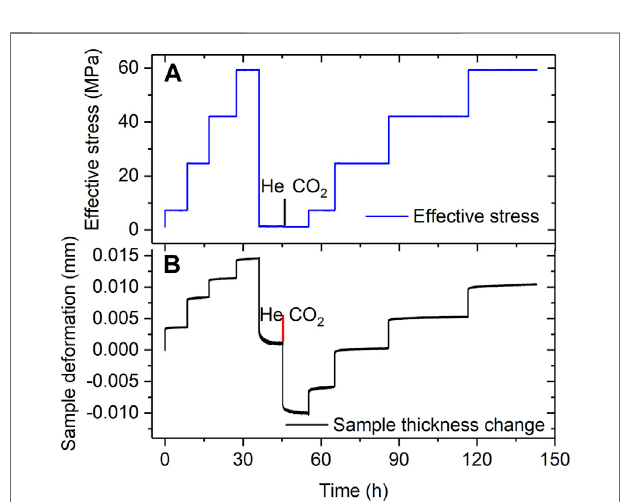
FIGURE 5 | Representative data obtained in Stage 3 experiments performed onVDsamplesusing pure(dry) He and CO 2 (illustrated here forthe VDCa-SAz-1sample). (A) StresspathemployedinrunsonVDsampleSAz-1, sequentially charged with dry He and dry CO 2 at a pressure of 10 MPa. (B) Corresponding sample thickness change versus experimental time. All data measured relative to the starting state in the Stage 3 experimental series.